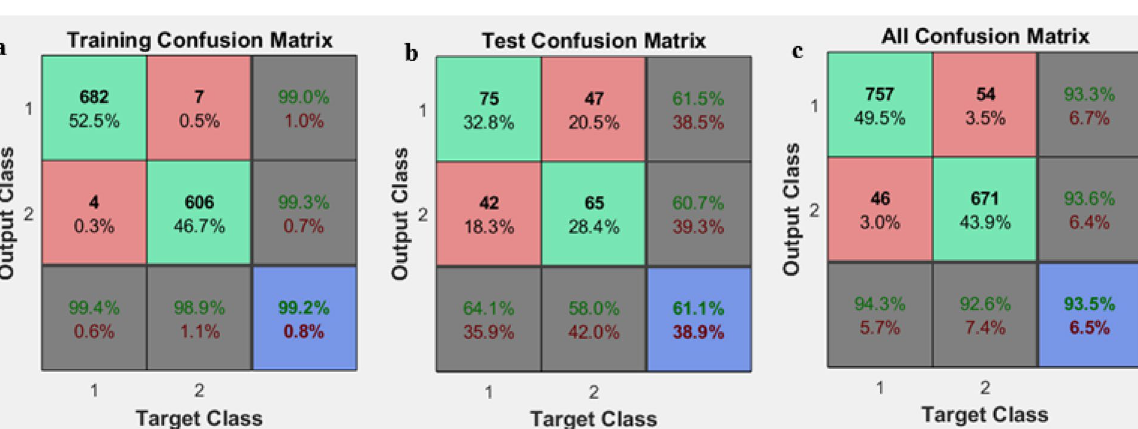
Figure 3. An example of confusion matrices after network implementation in traing ( a ) test ( b ) and all confusion ( c ).